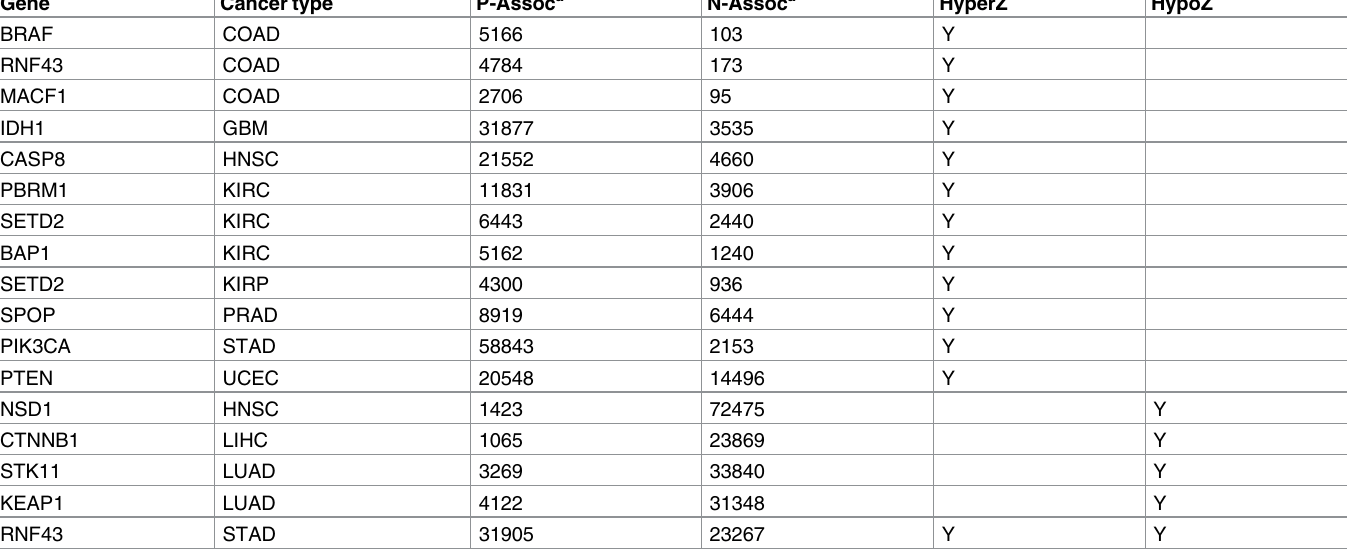
Table 3. Mutated driver genes that exhibit primarily positive or negative probe associations and correspond to a high HyperZ or HypoZ index in particular cancer types.